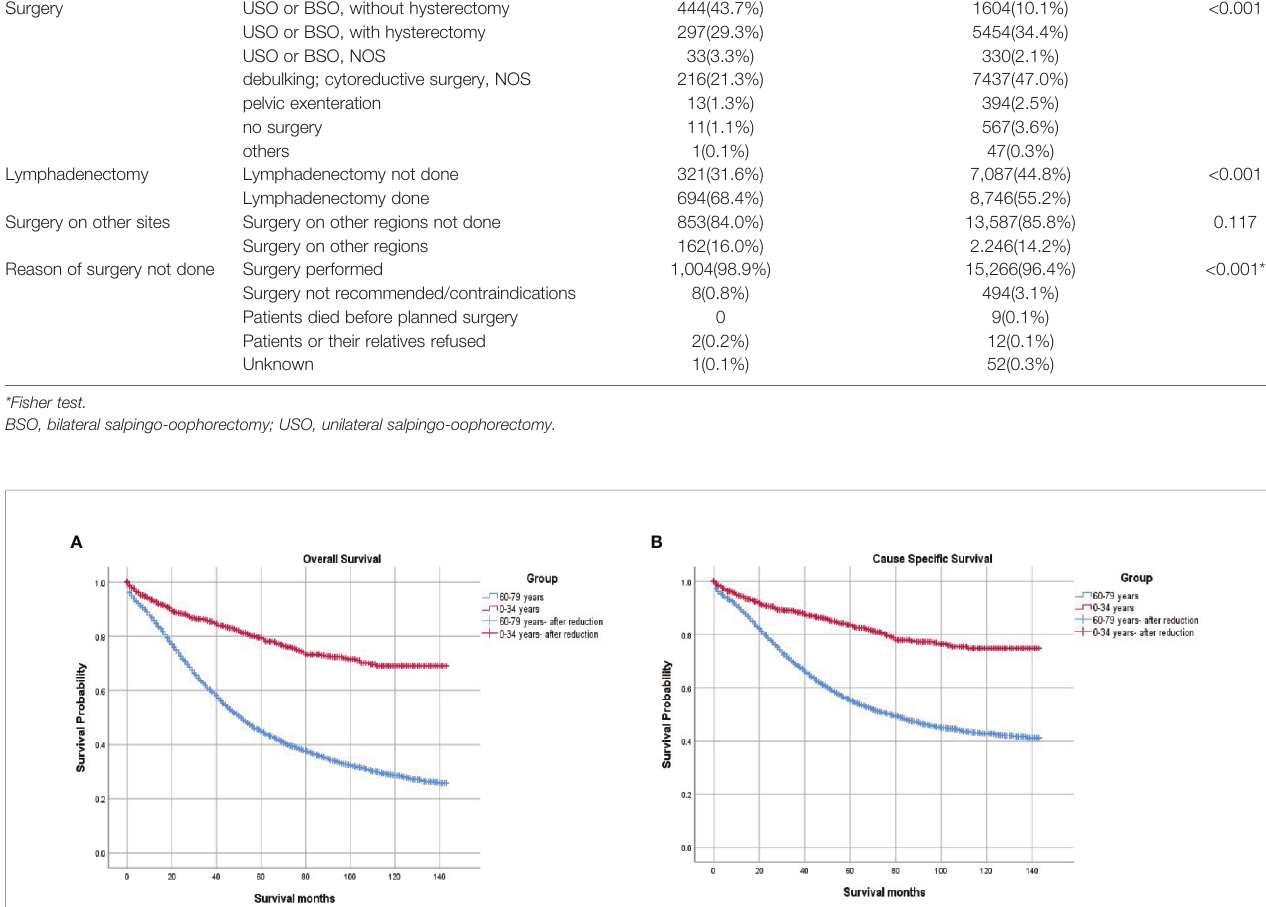
FIGURE 2 | (A) Overall survival and (B) Cause-speci fi c survival in women aged <35 and women aged 60 to 79 diagnosed with epithelial ovarian cancer.